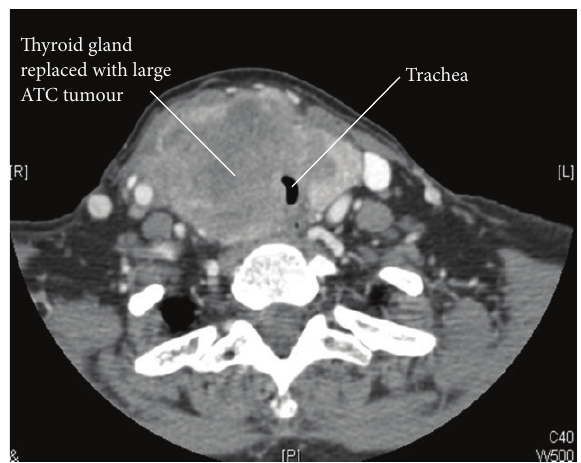
Figure 1: CT scan of patient with ATC causing tracheal compres-